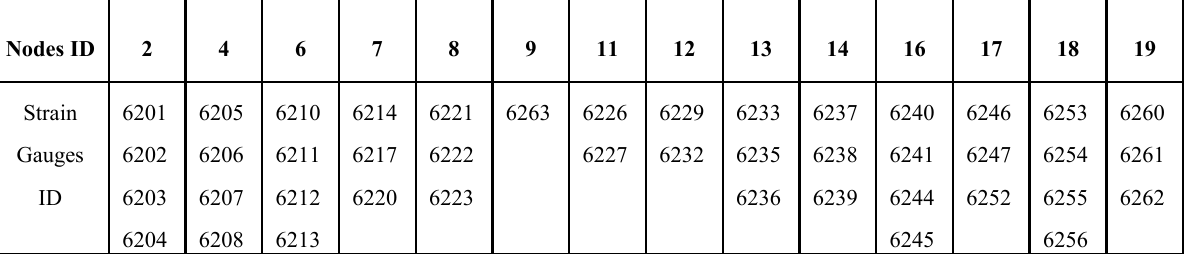
Table 4. The correspondence of connection between 43 strain gauges and 14 wireless sensor